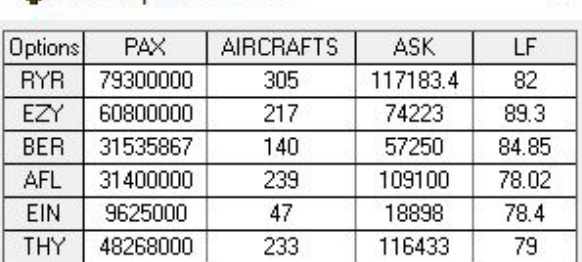
Figure 6: Transport Performance Data.